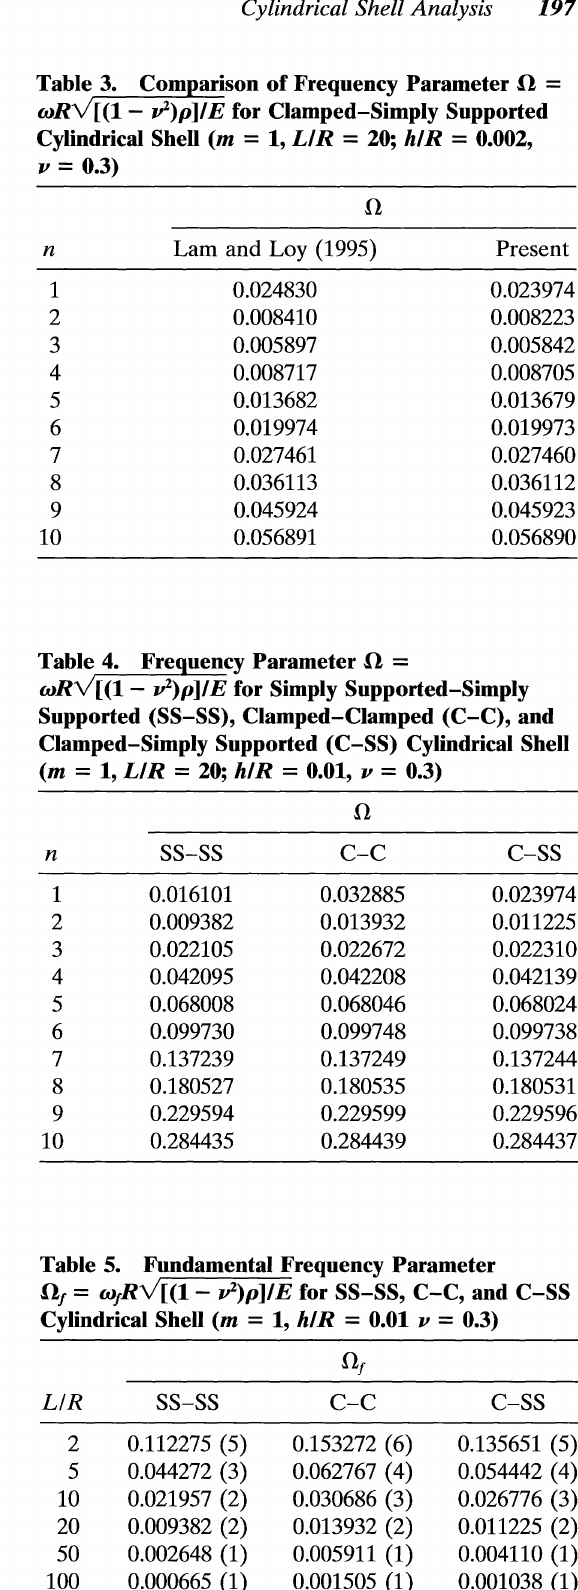
Table 1. Comparison of Frequency Parameter 0 = wRY[(1- ,r)p]IE for Simply Supported-Simply Supported Cylindrical Shell (m = 1, RIL = O.OS)